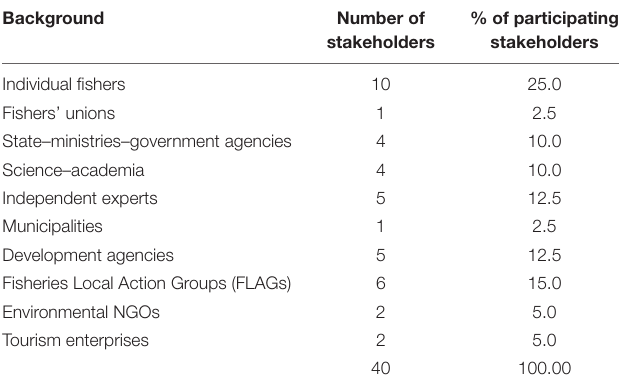
TABLE 1 | Breakdown of stakeholders that participated in the